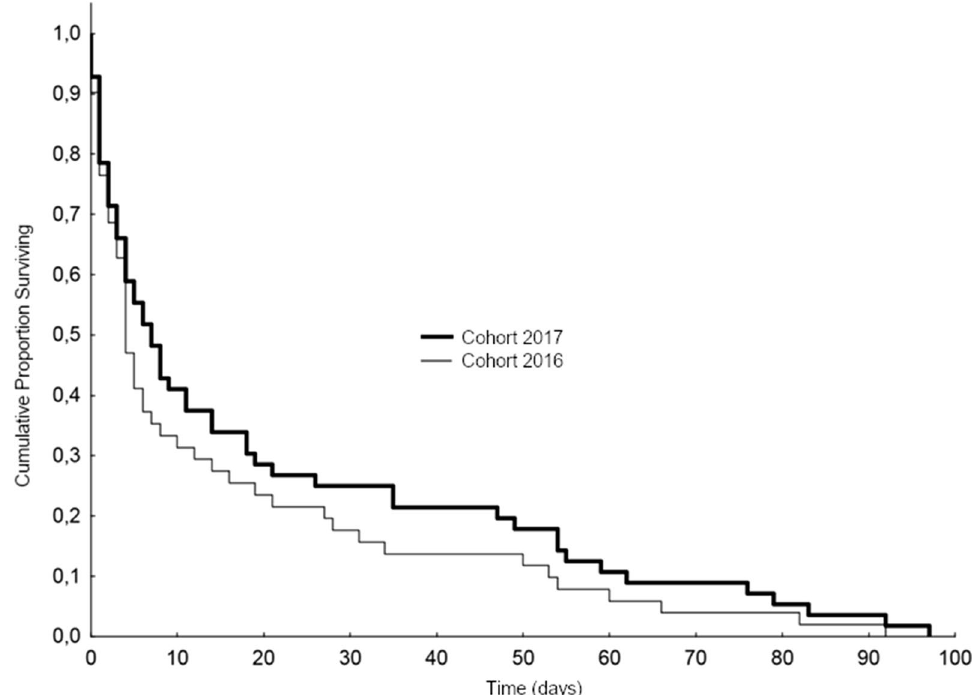
Fig. 2 Survival rates (2016 vs. 2017) in the Padua cohort among deceased patients at 3 months